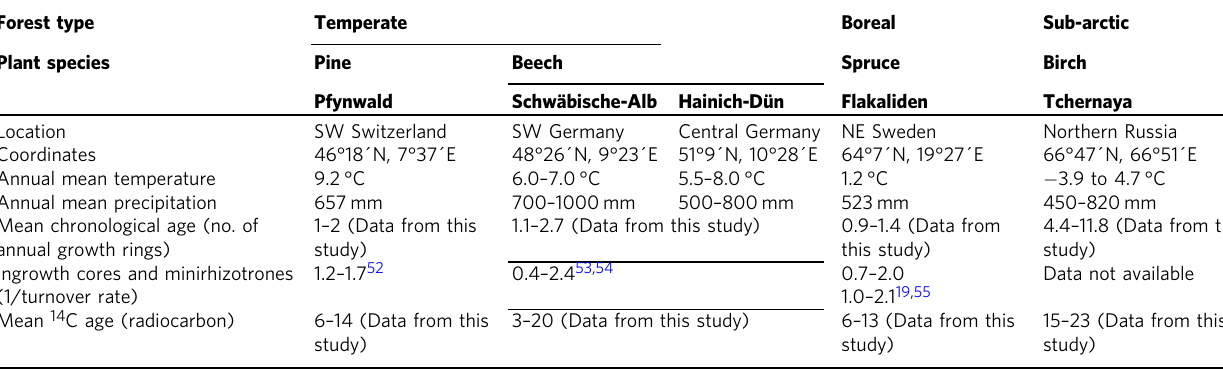
Table 1 Site characteristics and comparison of fi ne root lifetimes using different methods Forest type